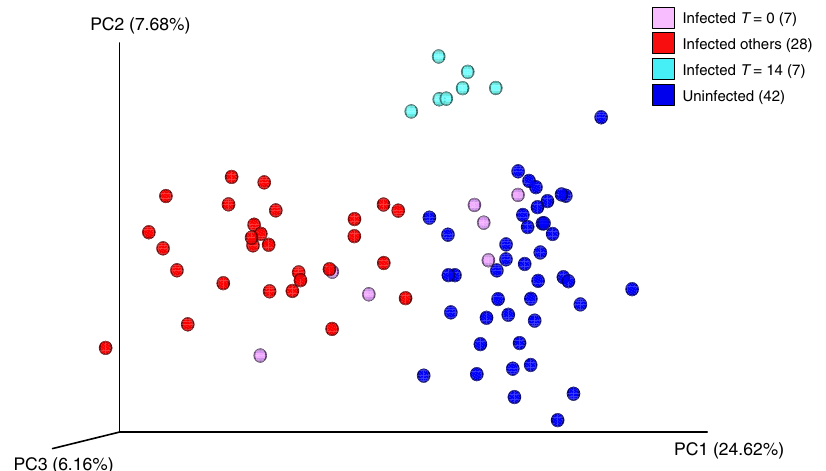
Fig. 3 Diversity of the URT microbiome in ferrets during IAV infection. Beta-diversity analysis for longitudinal URT samples taken after experimental infection with the A/Netherlands/602/09 H1N1 strain (Infected) or in control animals. Principal coordinates analysis (PCoA) of Bray – Curtis distances was performed for all samples. Data points for uninfected ferrets are in blue, the T = 0 for the infected ferrets in lavender, the T = 14 for infected ferrets in cyan, and all other infected time points were collected at 1 – 7 days post infection and shown are in red. The total variability explained by all three principal coordinates (PCs) is shown on the axes. Each group of ferret was composed of seven animals. Source data are provided as a Source Data fi